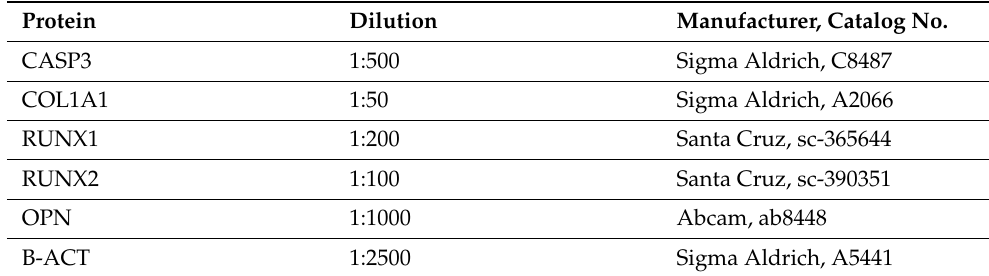
Table 1. List of antibodies used in western